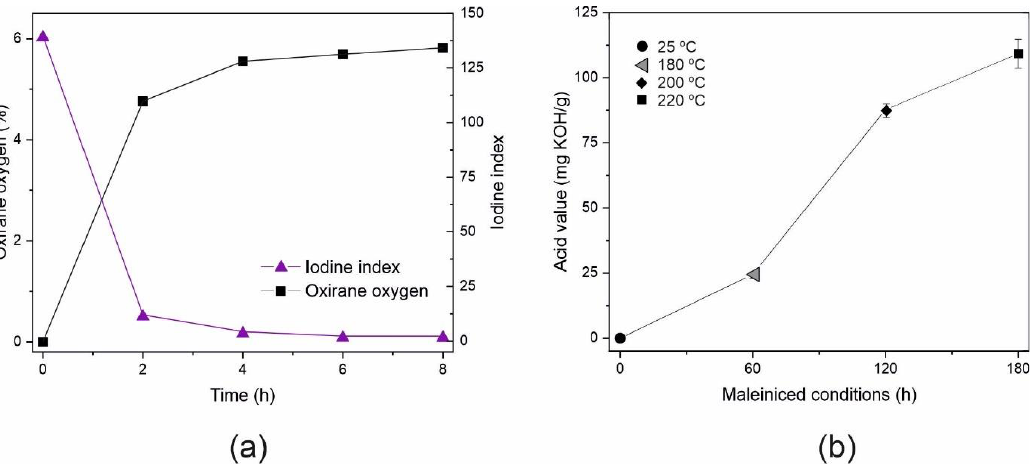
Figure 2. ( a ) Evolution of the oxirane oxygen index and iodine index in the corn oil epoxidation process and ( b ) evolution of the acid value in the different stages of the corn oil epoxidation process.